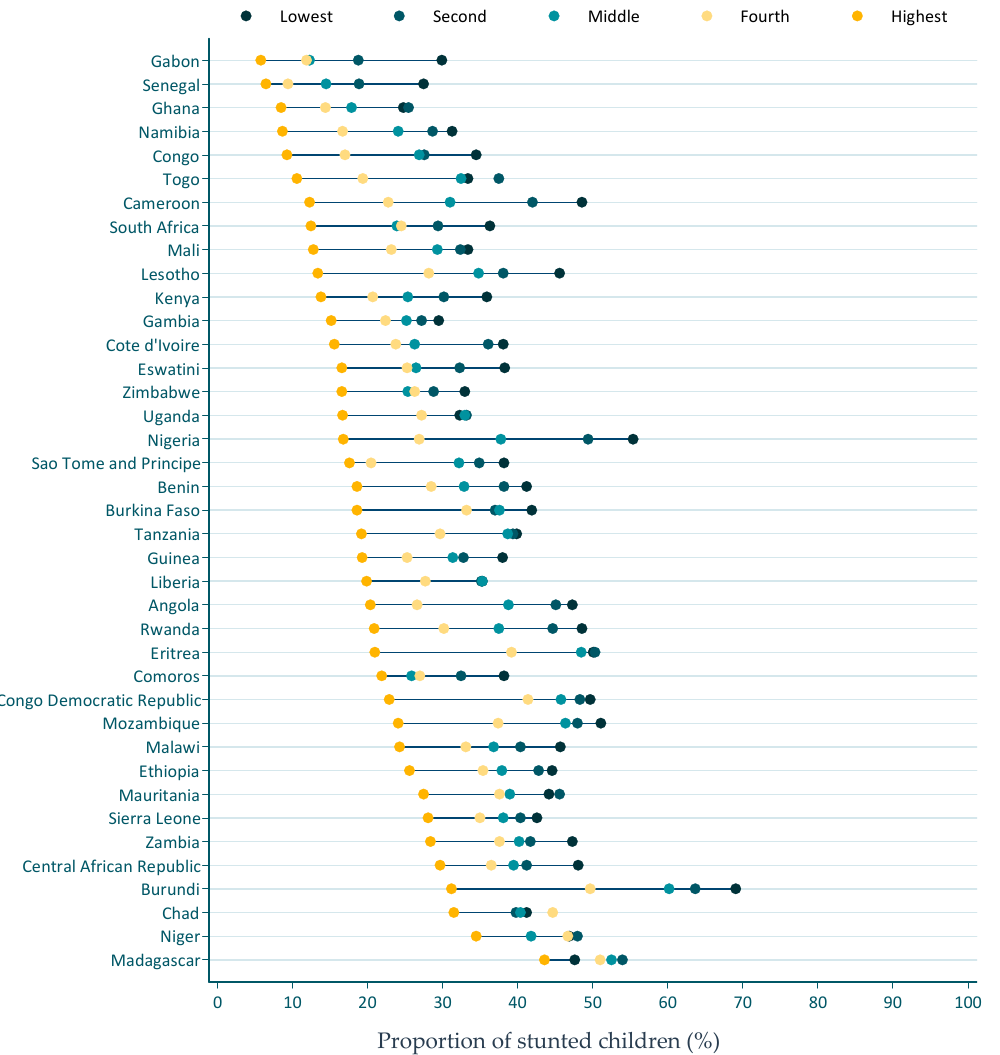
Figure 5. Stunting prevalence by wealth quintile. Dots represent estimated stunting prevalence for the poorest, second, middle, fourth, and the highest wealth quintile.